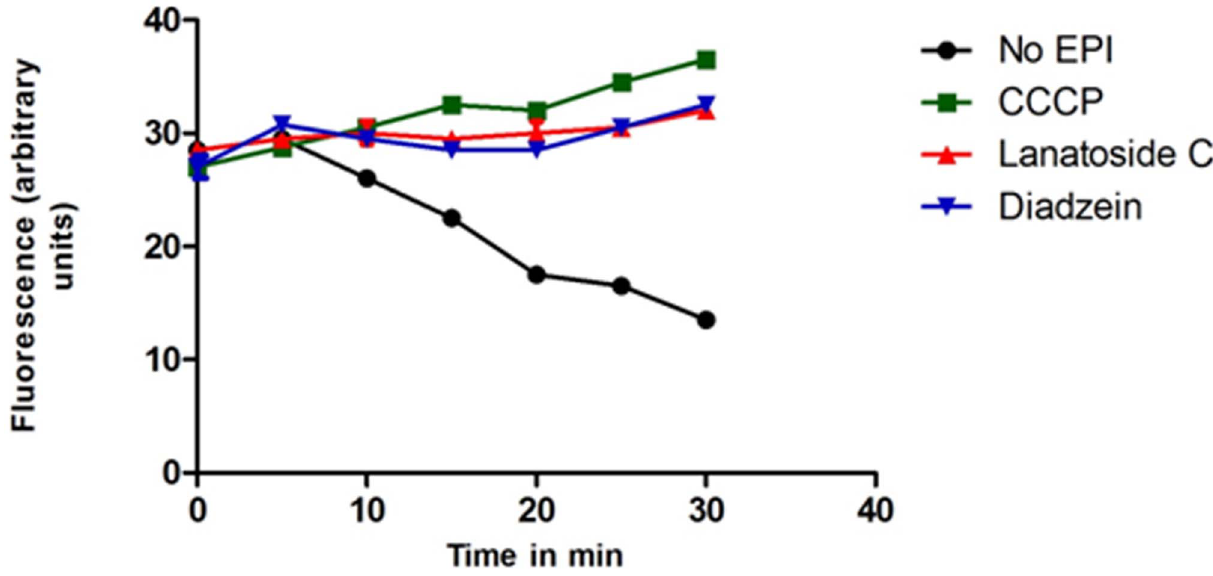
Figure 5. Effect of efflux inhibitor, CCCP and phytochemicals in accumulation of ethidium bromide in P.aeruginosa strain.